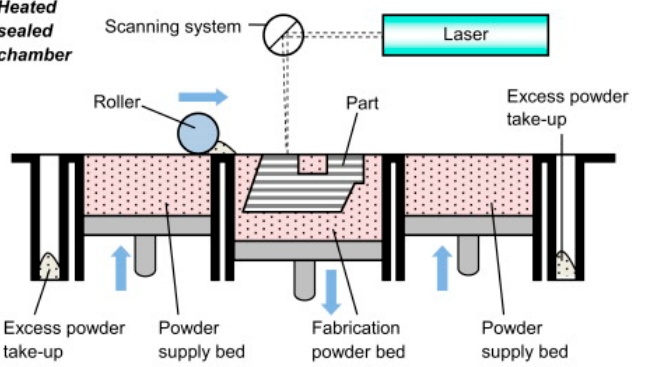
Figure 22. Selective laser sintering (SLS) process (adapted with permission from reference [59]).